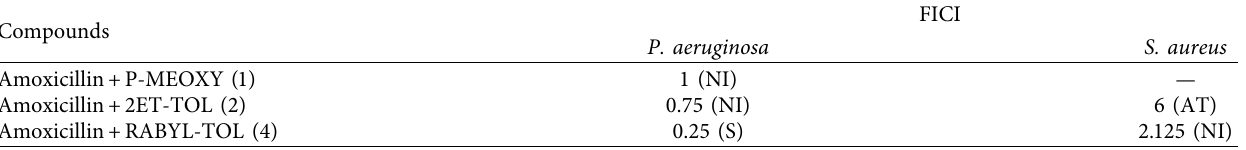
Table 2: Fractional Inhibitory Concentration Indices of the combination of the compounds and Amoxicillin.